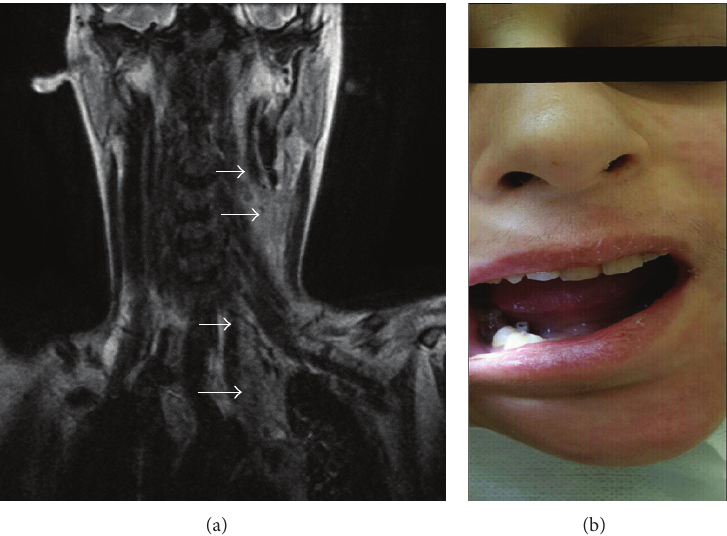
Figure 1: (a) Cervical MRI images (coronal section) that show multiple abscess formation in left carotid space from skull base to the mediastinum and submental lymphadenopathy. (b) The images of the patient after tooth extraction and a Penrose drain application by the consultant